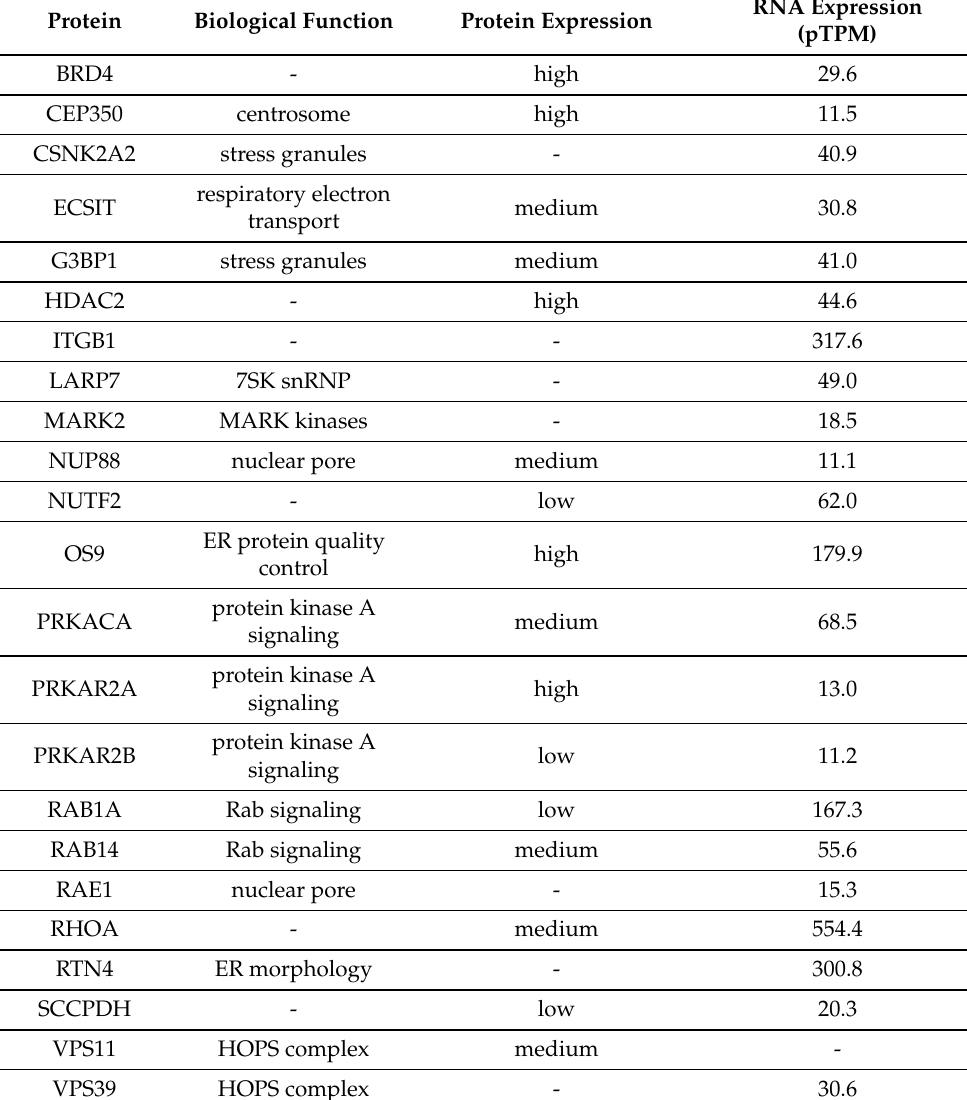
Table 2. Proteins found here to be perturbators of PD-VPs. Biological functions are reproduced from Gordon et al. [65] and the data about protein and RNA expressions are taken from The Human for